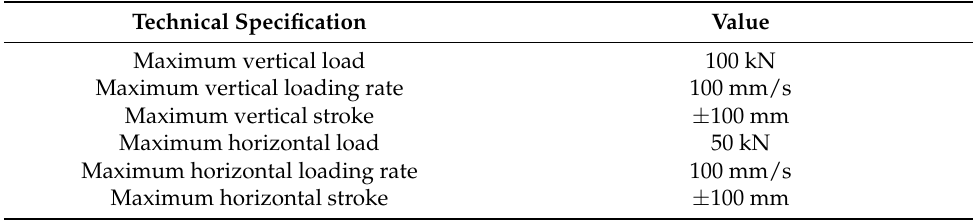
Figure 3. Test setup: ( a ) friction testing machine and setup; ( b ) shape and dimensions of ceramic friction material specimen; ( c ) ceramic friction material. Table 1. Specifications of testing